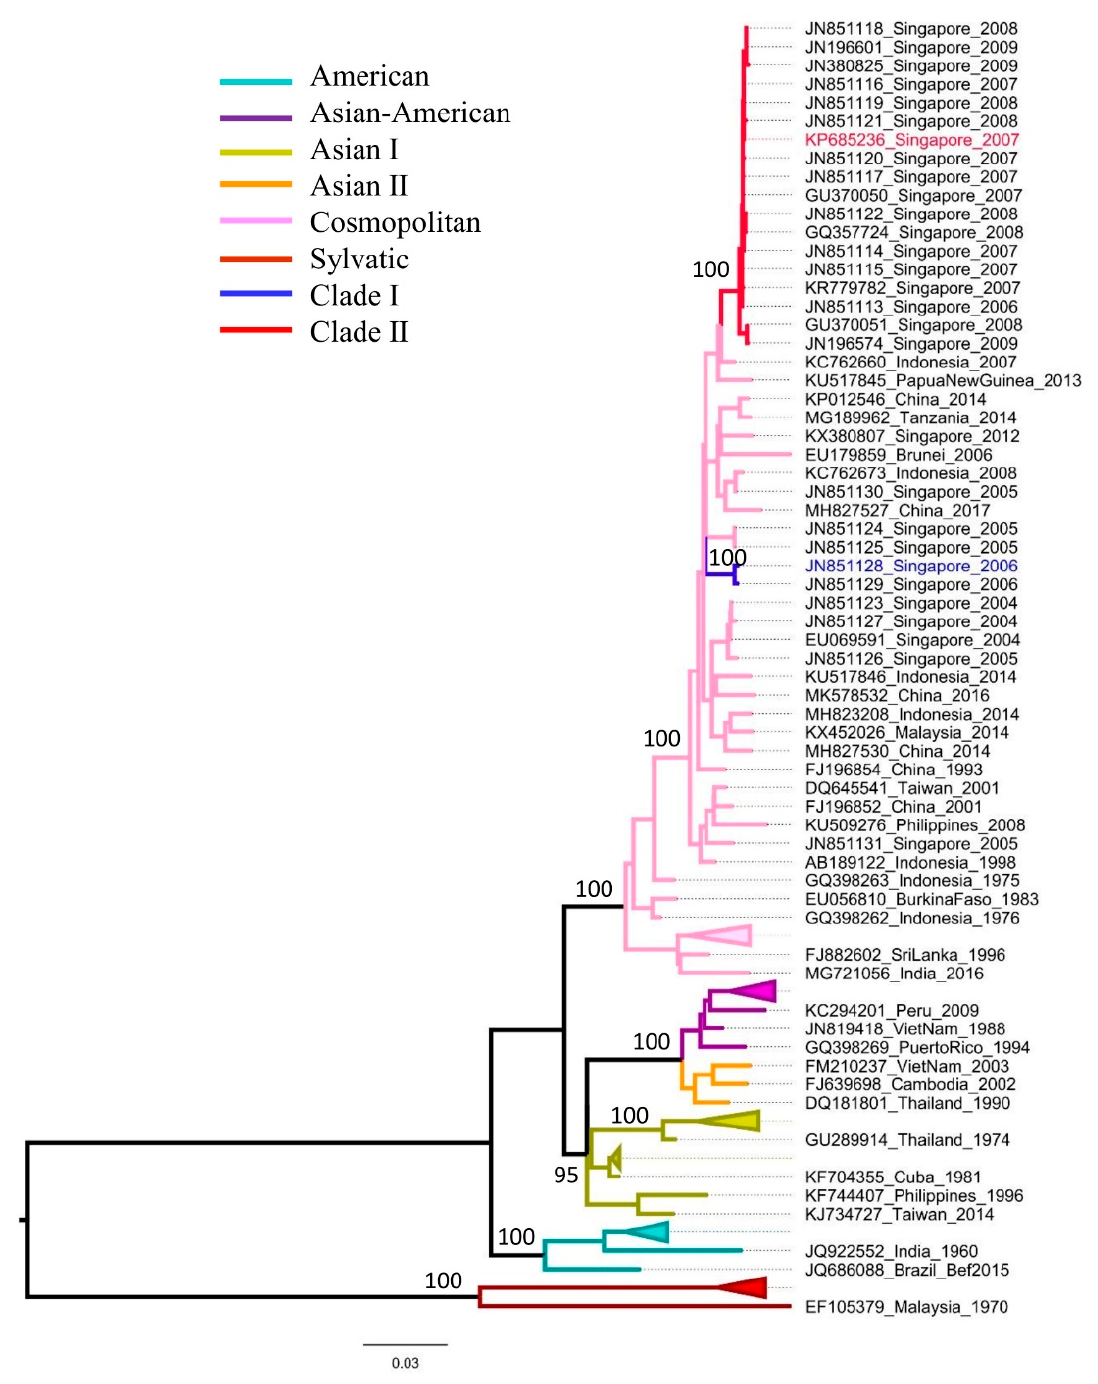
Figure 1. Phylogenetic analysis to illustrate the genetic distinction between clades I and II. The whole polyprotein-based maximum likelihood tree was constructed in the MEGA7 program [23]. The dataset included 28 whole polyprotein sequences of clade I and clade II reported in Singapore from 2004 to 2009 and 63 sequences retrieved from the GenBank database to represent different genotypes of DENV-2. Genotypes and clades are shown in different colors as noted in the legend. The taxa names of isolates used in the present study are colored in each clade. The numbers on branches show bootstrap support values.